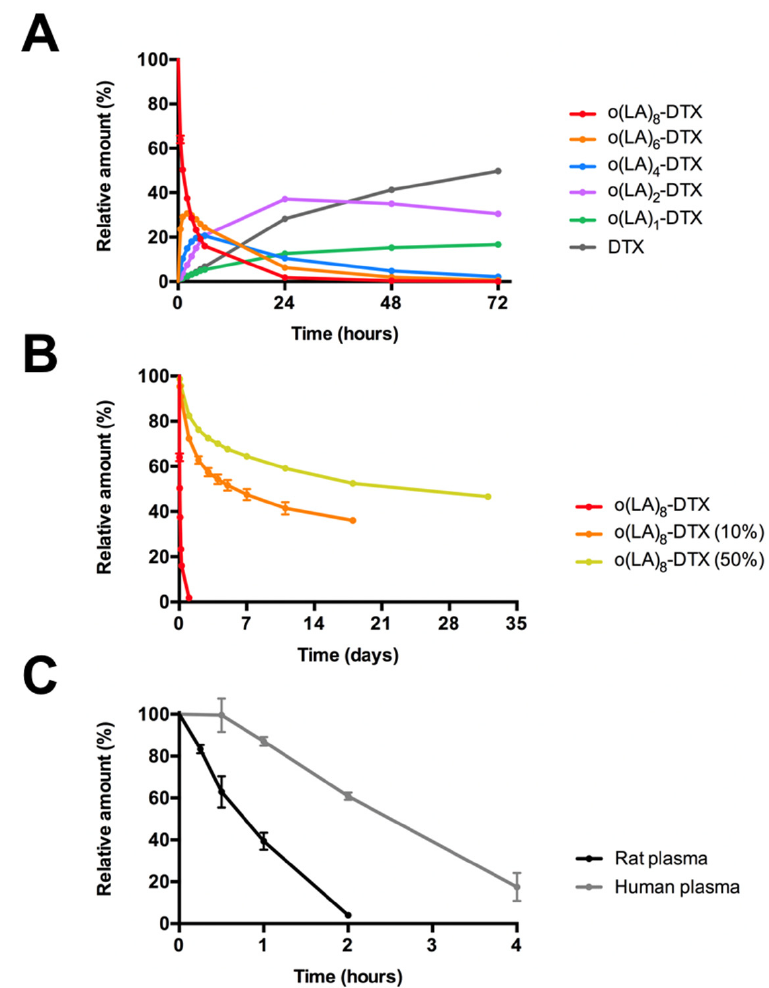
Figure 4. In vitro conversion and stability of o(LA) 8 -DTX at 37 °C (n = 3, mean ± SD). ( A ) Relative amounts of o(LA) 8 -DTX and each intermediate species after incubation in a 1:1 mixture of ACN and 10 mM PBS, pH 7.4 at 1 mg/mL. ( B ) Stability of o(LA) 8 -DTX in free form or in micelles at 1 mg/mL in PBS. ( C ) In vitro stability of o(LA) 8 -DTX incubated in rat or human plasma at a final concentration of 50 µ M. Importantly, these results show that the structure of o(LA) 8 -DTX remains preserved within the micelle, but upon release, it is quickly converted to active DTX through backbiting or esterase-mediated degradation for drug